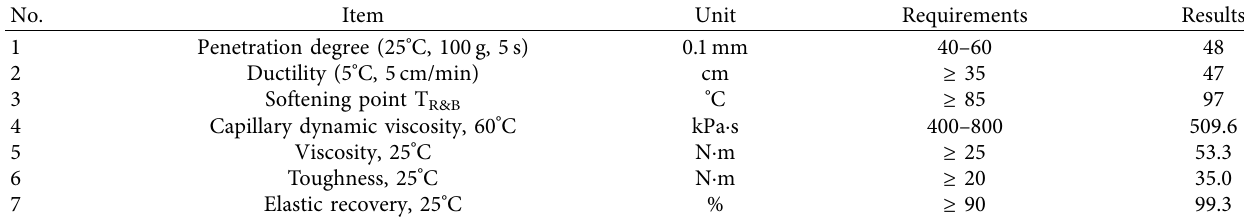
Table 1: Technical properties of high-viscosity polymer-modified asphalt.